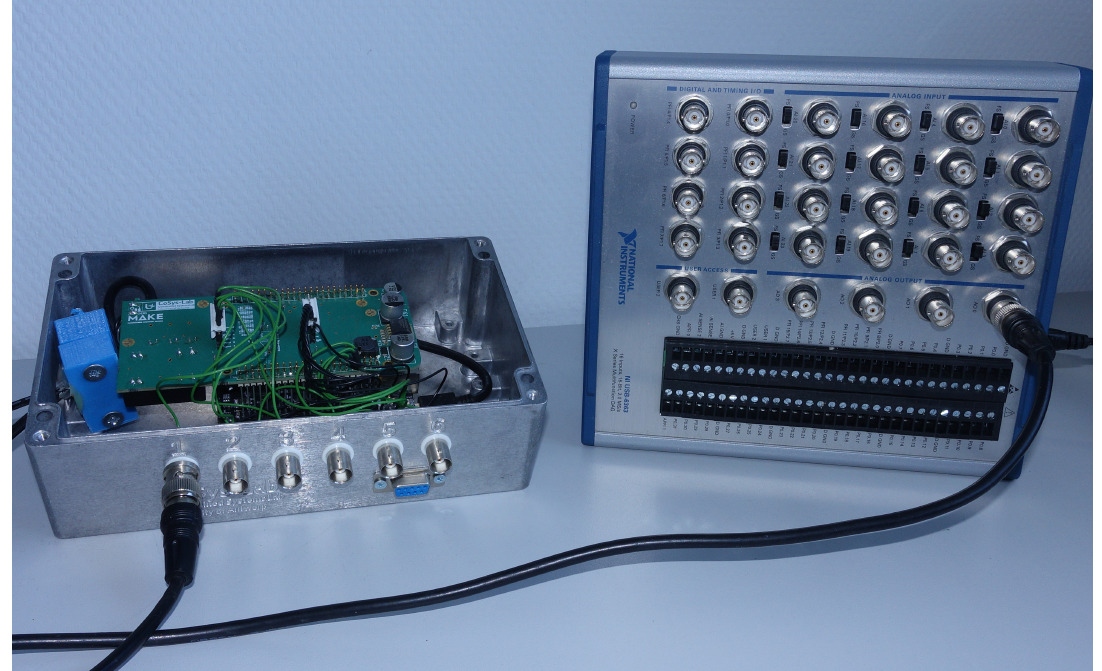
Figure 6. Picture of the test setup used to generate a test signal with a known frequency. The test signal was generated using Matlab and a National Instruments USB-6363 DAQ, which can be seen on the right side in the picture. The test signal is captured using the previously developed hardware, which can be seen on the left and is discussed in more detail in Section 2.3, in combination with an automatically generated firmware and control software using the proposed framework. The timing diagram is modeled for the ADS8556 to sample at 125 kHz in combination with a Beaglebone Black with a clock speed of 200